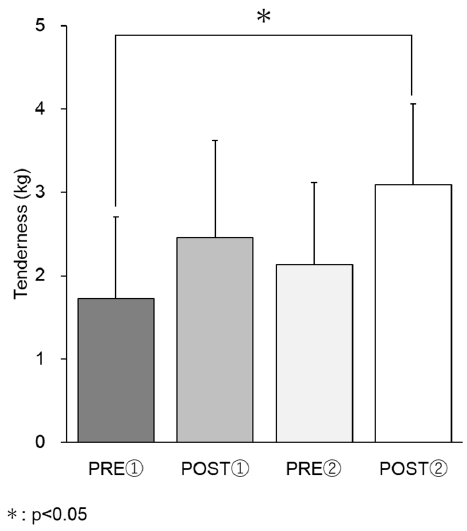
Figure 4. Tenderness.